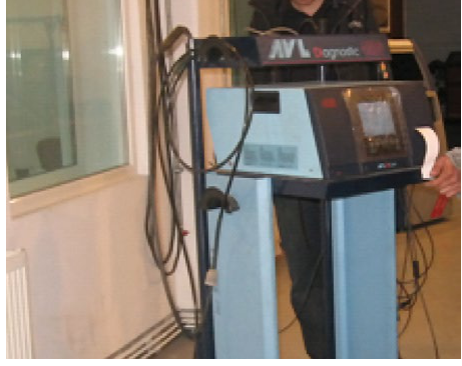
Fig. 3. Dicom 4000 gas